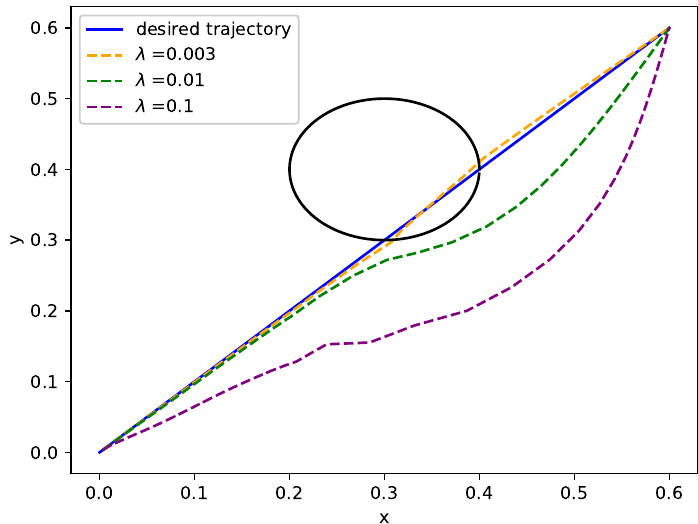
Figure 2. Obstacle avoidance behavior with different values of λ